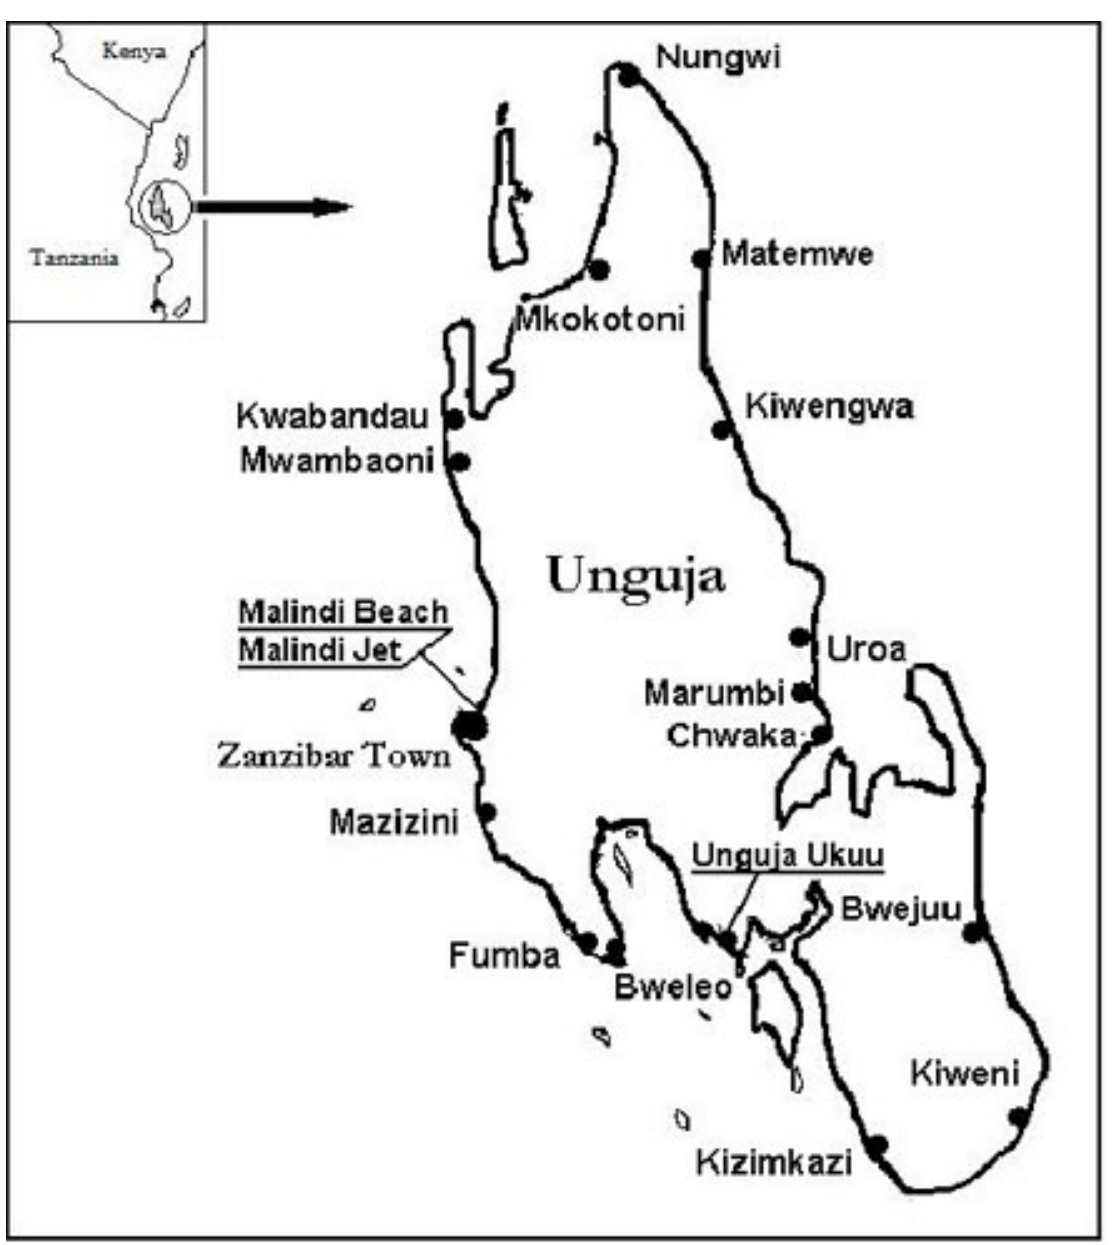
Fig. 2. Villages in which Bwana Dikos are placed and extensive data collection takes